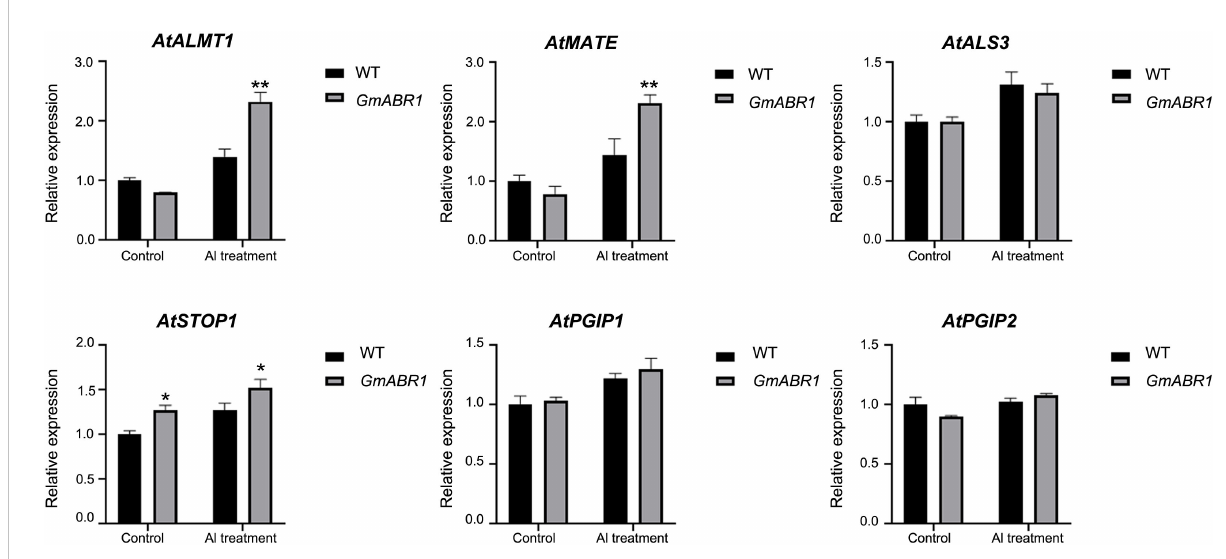
FIGURE 6 Expression patterns of Al stress responsive genes regulated by GmABR1 in Arabidopsis. Arabidopsis were cultured in solid medium supplemented with 0 and 100 m M AlCl 3 (pH4.5) for 7 days, respectively. The expression patterns of Al stress responsive genes by GmABR1 were detected. Using Arabidopsis Tubulin as the internal reference gene, qRT-PCR was used to detect the gene expression level before and after Al treatment. The asterisks indicated that the transcripts of investigated genes in GmABR1 transgenic lines were signi fi cantly different from those of WT treated with and without AlCl 3 ( *P < 0.05; **P < 0.01). The information of gene sequences was from the NCBI database (https://www.ncbi.nlm.nih.gov/). qRT-PCR primer information used in this experiment was shown in Table S2.